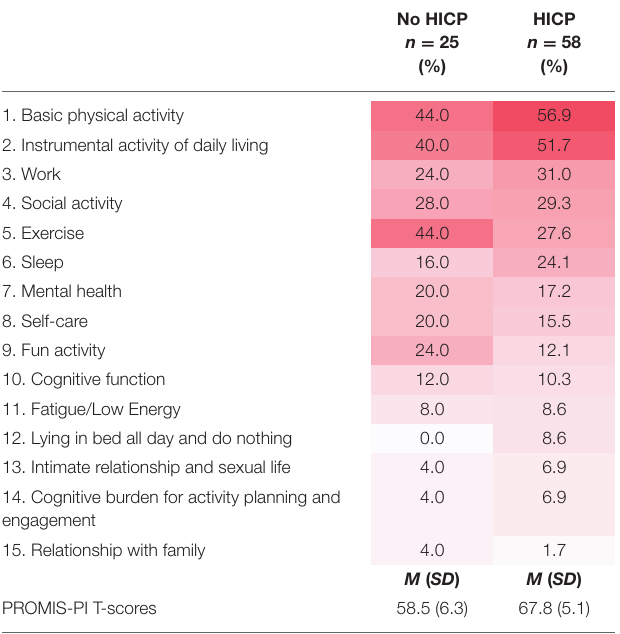
TABLE 4 | Comparing the three major areas of pain impact between adults and older adults with and without HICP.